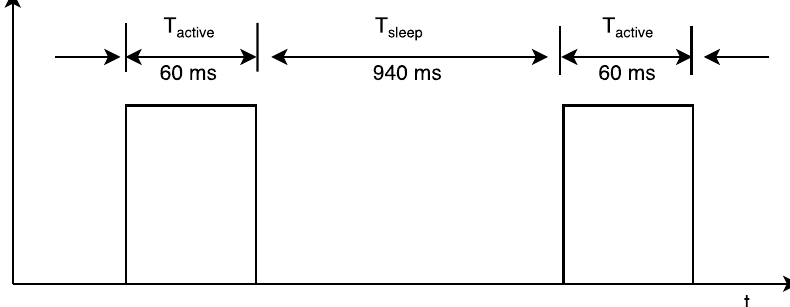
Figure 7. Schematic representation of the implemented duty